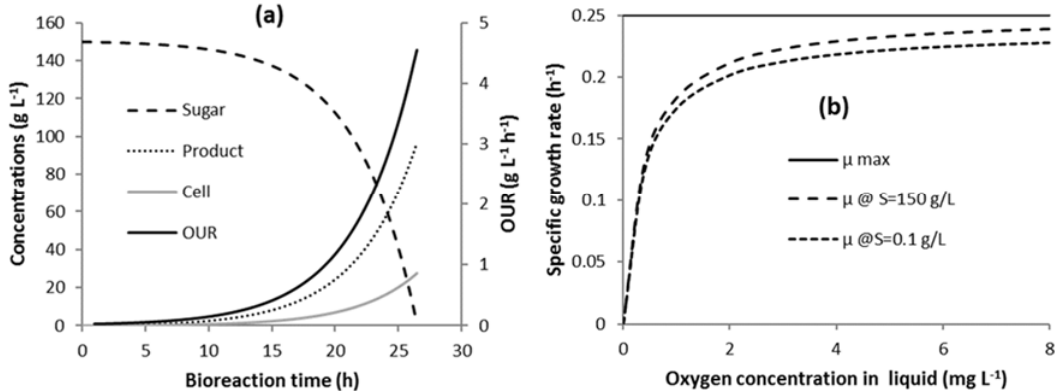
Figure 2. Bioreaction kinetics: ( a ) Cell, sugar, and product concentrations and oxygen uptake rate (OUR) (Strategy C1: C OL = 2 mg L − 1 , Pag = 38.5 kW); and, ( b ) effect of oxygen concentration and sugar concentration (S) on specific growth rate.